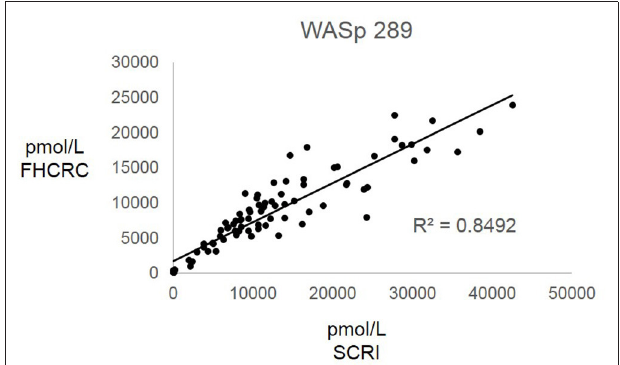
FIGURE 4 | Inter-laboratory analytical validation of WASp 289. SCRI, Seattle Children’s Research Institute; FHCRC, Fred Hutchinson Cancer Research Center.